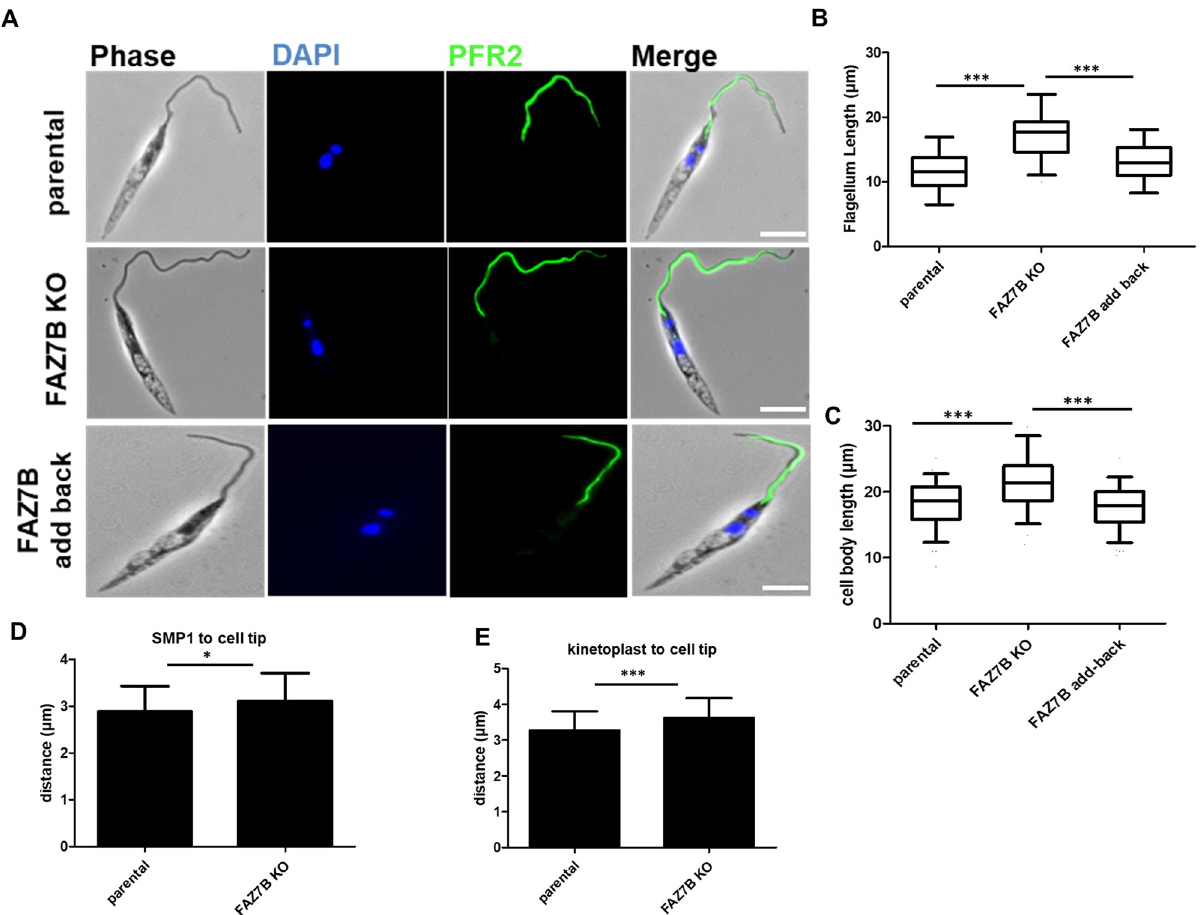
Fig 4. Loss of FAZ7B alters promastigote cell morphology. (A) Immunofluorescence assay. Parental, FAZ7B KO and add-back representative cells labelled using anti-PFR2 antibody (green). Scale bar: 5 μ m. (B) Flagellum and (C) cell body length measurements of parental, FAZ7B KO and add-back cell lines. Cells were fixed with PFA at a density of 1x10 7 cells/mL. Boxes and error bars indicate the median, upper and lower quartiles and 95 th percentiles. ��� p < 0.001 (Student’s t -test). (D-E) Measurement of the distance between the SMP1 signal (D), kinetoplast (E) and the anterior end of the cell body in parental and FAZ7B KO cell lines. One hundred cells were counted per sample. Boxes and error bars indicate the median, upper and lower quartiles and 95 th percentiles. ��� p < 0.001; � p < 0.05 (Student’s t -test).